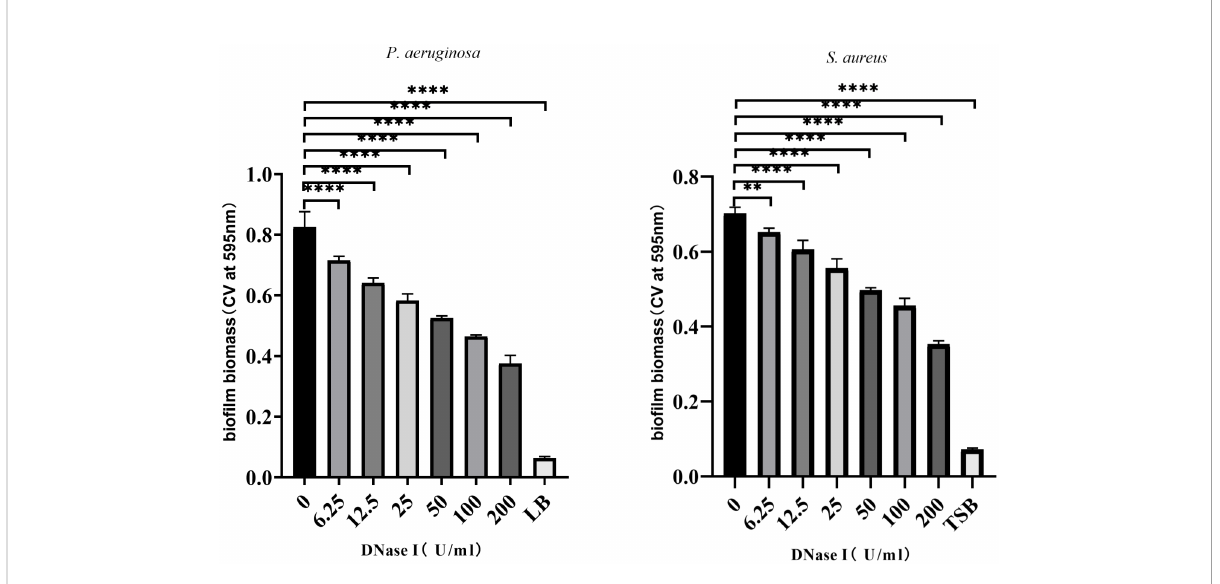
FIGURE 2 DNase I inhibition of bio fi lm formation by P. aeruginosa or S. aureus strains. The bio fi lms were stained with crystal violet and detected by OD 595 measurements. The results are presented as mean ± SD. An asterisk indicates a signi fi cant difference, ** indicates p < 0.01 and **** indicates p < 0.0001, compared with the results in the drug-free control group using one-way ANOVA (n = 3). ANOVA tests. LB, Luria-Bertani; TSB, tryptic soy